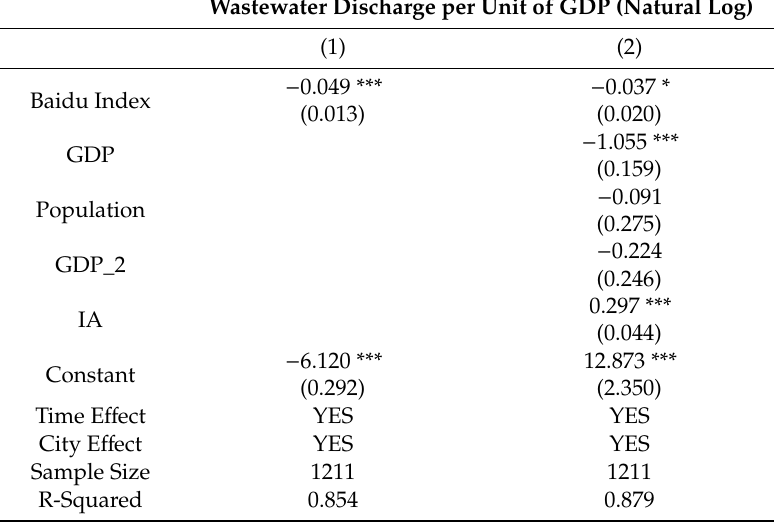
Table A1. The e ff ects of bottom-up pressure on water